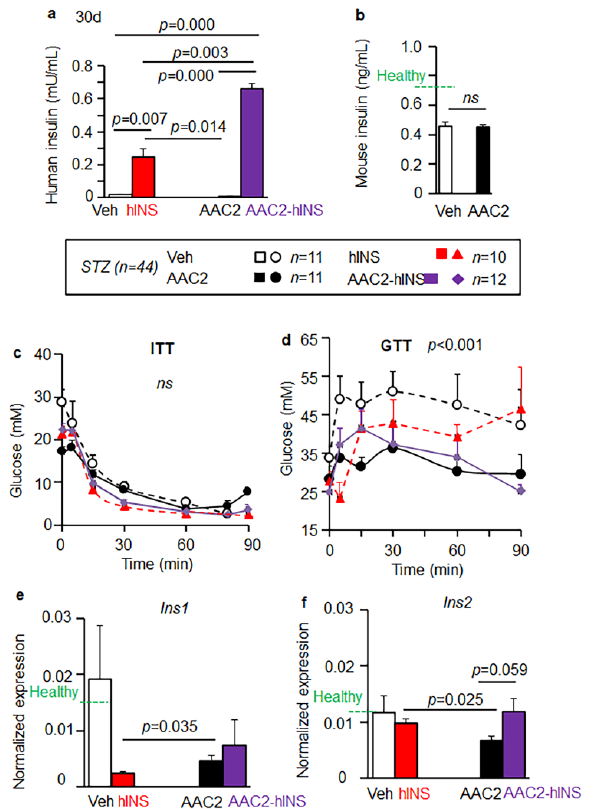
Figure 5. AAC2-hINS treatment vs. free hINS increased levels of circulating therapeutic hINS and expression of endogenous insulin in the brain. ( a ) The plasma levels of therapeutic hINS were measured three days after the last treatment (30 d). For overall comparison, a Kruskal–Wallis test with a Mann–Whitney U-test for post hoc testing, p = 0.001. ( b ) The plasma levels of endogenous mouse insulin mice were measured in the same samples. n.s.—Student’s independent t ‐ test. ( c ) Insulin tolerance test (ITT) in the STZ mice was performed one day after treatment administration. One ‐ way ANOVA. ns. ( d ) Glucose tolerance test (GTT) in STZ mice. Overall comparison, p = 0.001. ( e , f ) Expression levels of mouse Ins1 ( e ) or Ins2 ( f ) in the STZ mouse brain tissues were measured by a Taqman Mann–Whitney U test. Dashed line, levels in healthy mice ( n = 6).